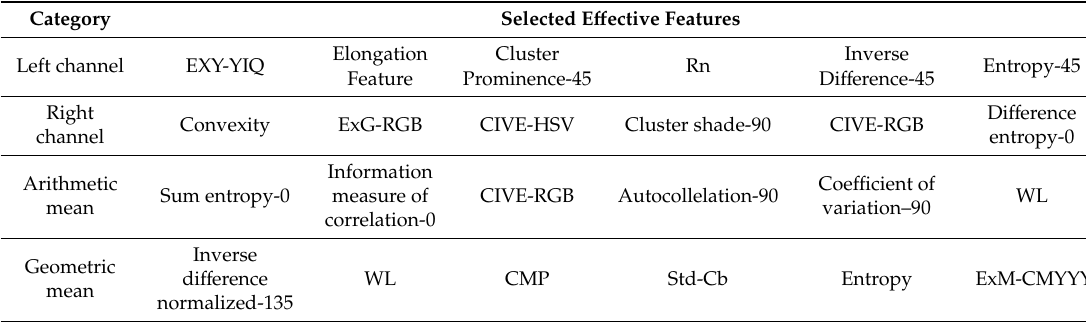
Table 2. The most e ff ective features selected by the proposed hybrid ANN-PSO algorithm from the left Table 2. The most effective features selected by the proposed hybrid ANN-PSO algorithm from the and right channel data and arithmetic and geometric left and right channel data and arithmetic and geometric means.